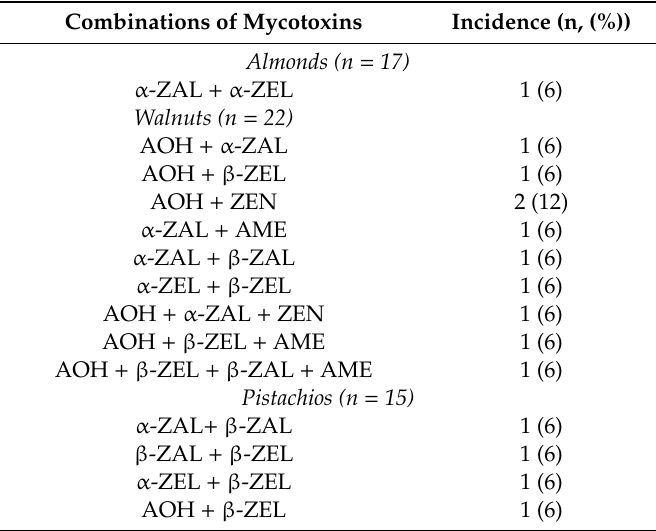
Table 4. Co-occurrence of mycotoxins in the analyzed tree nuts. Combinations of